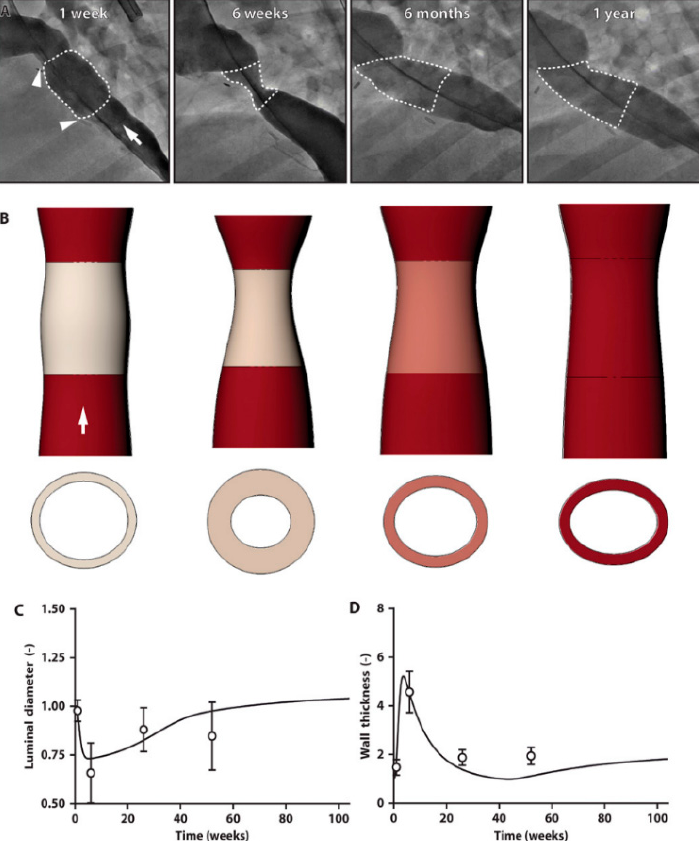
Figure 5. TEVG stenosis spontaneously reverses in an ovine model [108]. ( A ) Serial angiographic images of a representative ovine TEVG 1 week, 6 weeks, 6 months, and 1 year after implantation. Anastomoses are identified with white arrowheads, and the TEVG is identified by a white dotted outline. White arrow indicates direction of blood flow. ( B ) Image reconstructions of serial IVUS and angiographic measurements of luminal area, wall thickness, and length of the TEVG, confirming the development of stenosis at 6 weeks but spontaneous resolution by 6 months after implantation. White arrow indicates direction of blood flow. When based on lamb data, the model simulations (solid lines) for the midgraft. ( C ) Luminal diameter and ( D ) wall thickness fit well the hydraulic diameters calculated from the IVUS measurements (symbols) over the 1-year study. Ovine IVUS measurements are represented as means ± SD ( n = 22 at 1 week, n = 22 at 6 weeks, n = 20 at 6 months, n = 15 at 1 year). The Institutional Animal Care and Use Committee of Nationwide Children’s Hos- pital (Columbus, OH, USA) reviewed and approved the protocol for the ovine study (AR13- 00079